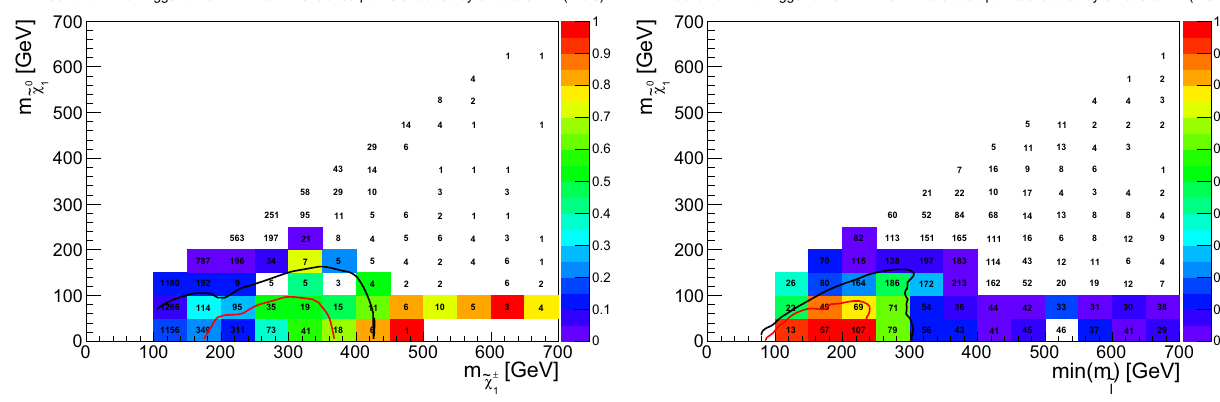
Fig. 13 Coverage of EW-inos and sleptons by EW analyses analogous to the right plots of Figs. 11 and 12 but considering points with r max > 0 . 8 (instead of r max > 1) as